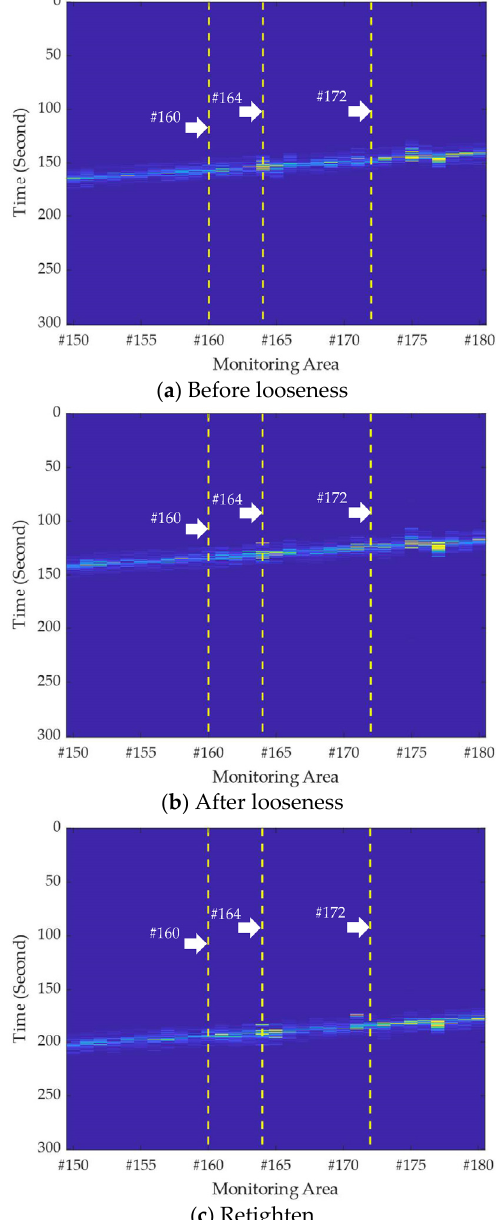
Figure 3. Vibration intensity versus space and time under the moving of rail inspection vehicle corresponding to ( a – c ) three fastener states.